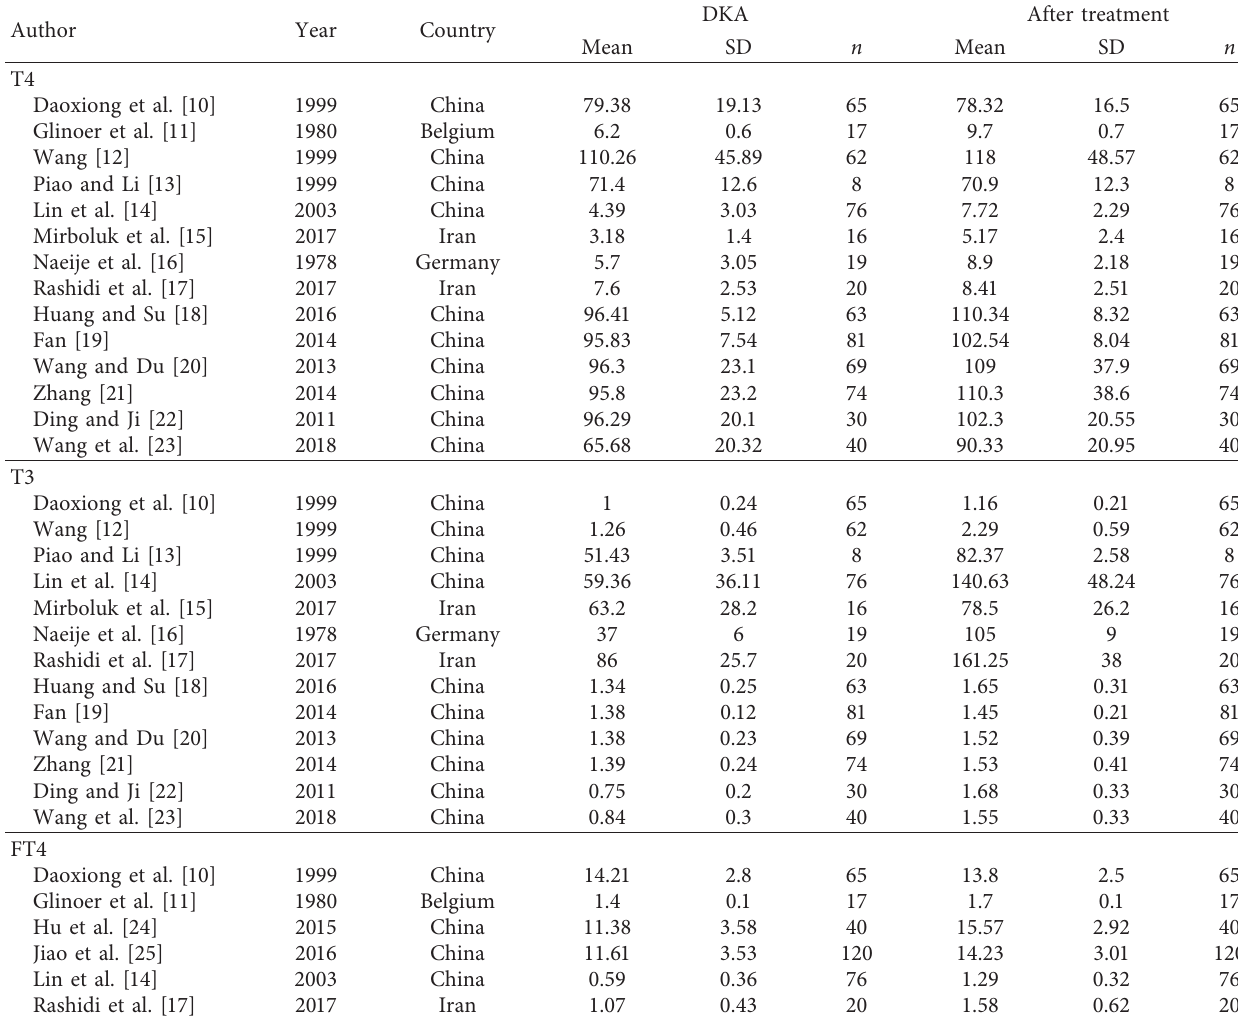
Table 2: Comparison of thyroid function before and after treatment in patients with diabetes and